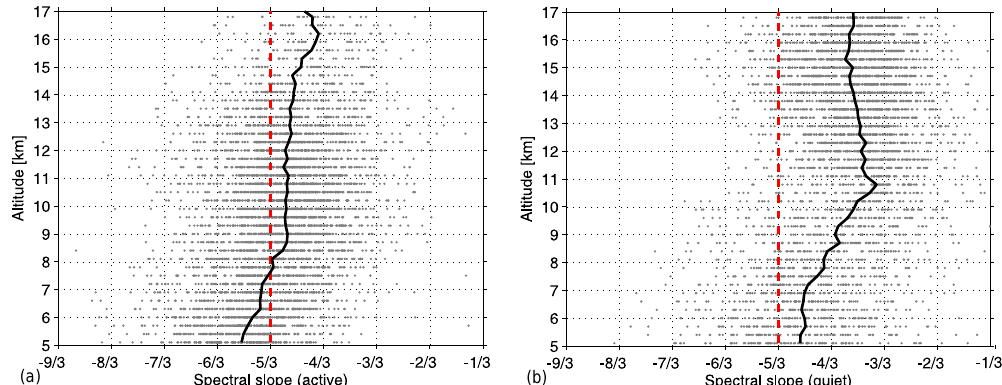
Figure 7. Scatter plots of spectra of vertical wind velocity during active (a) and quiet periods (b) . The black lines indicate the mean profiles of the spectral slope along the altitudes. The theoretical − 5/3 spectral slope is indicated by the red dashed line.